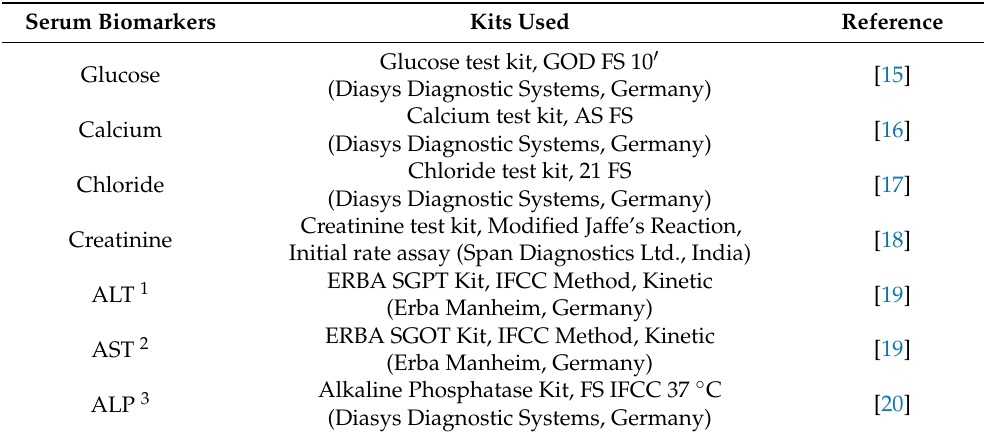
Table 1. The details on the serum biomarkers tested and kits used to assess the effect of dietary florfenicol in Oreochromis niloticus . Serum Biomarkers Kits Used Reference